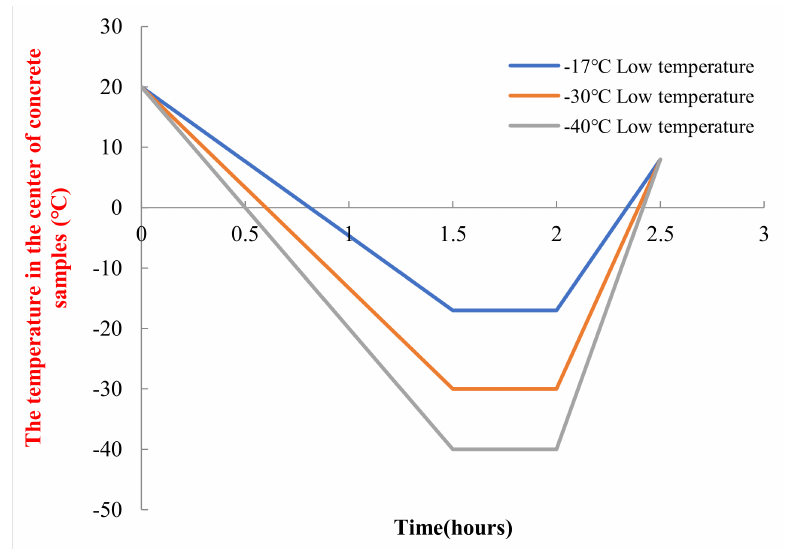
Figure 1. Temperature curve of a freeze–thaw cycle under different low